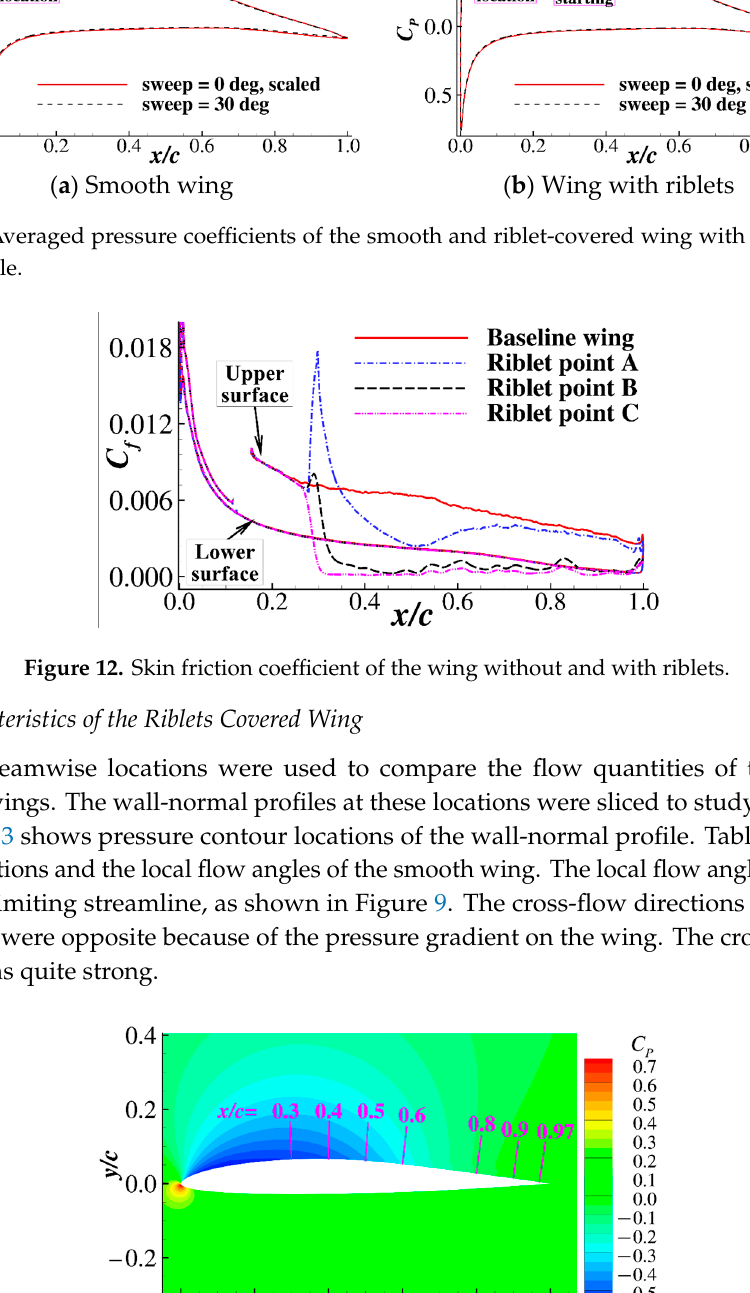
Figure 13. Pressure coefficient contour and streamwise locations. Table 3. Streamwise locations and local flow angles.